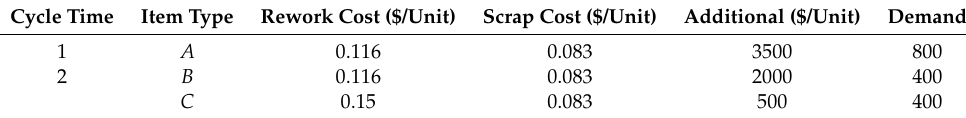
Table 4. Data of reworking operations with demand.